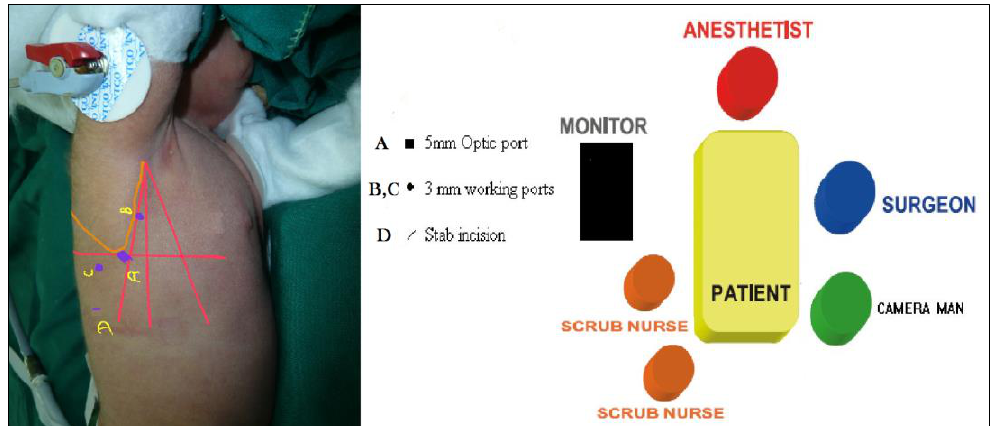
Figure 1: Operative team and instruments and patient positions.